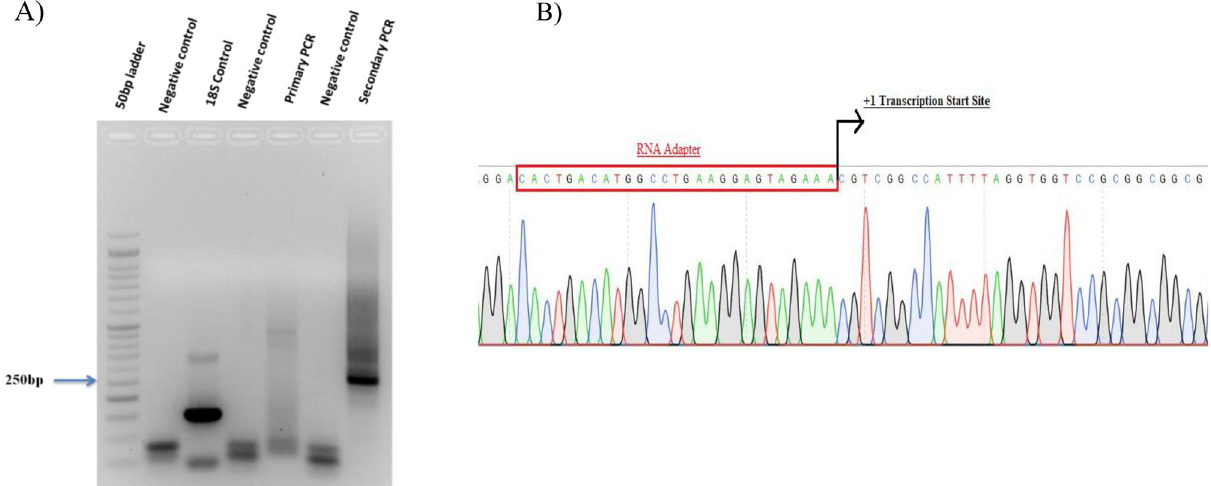
Figure 2. Mapping of of hnRNPD transcription start site in oral cancer cells. ( A ) RLM-RACE assay was used for mapping the transcription initiation site of human hnRNPD gene. Total RNA isolated from SCC-4 cells after treatment with Calf Intestinal Phosphatase (CIP) was decapped with tobacco acid pyrophosphatase. Then GeneRacer RNA adaptor was ligated to the 5 ʹ end of mRNA using T4 RNA Ligase. The adaptor ligated mRNA was reverse transcribed and subjected to primary and secondary PCR using nested adaptor and gene specific primers. 18S RNA was reverse transcribed and used as positive control and PCR reaction without template served as negative control. The PCR products were reolved on 1.2% agarose gel. ( B ) The prominent 250 bp band obtained after secondry PCR was subjected to double strand DNA sequencing after clonning into TA